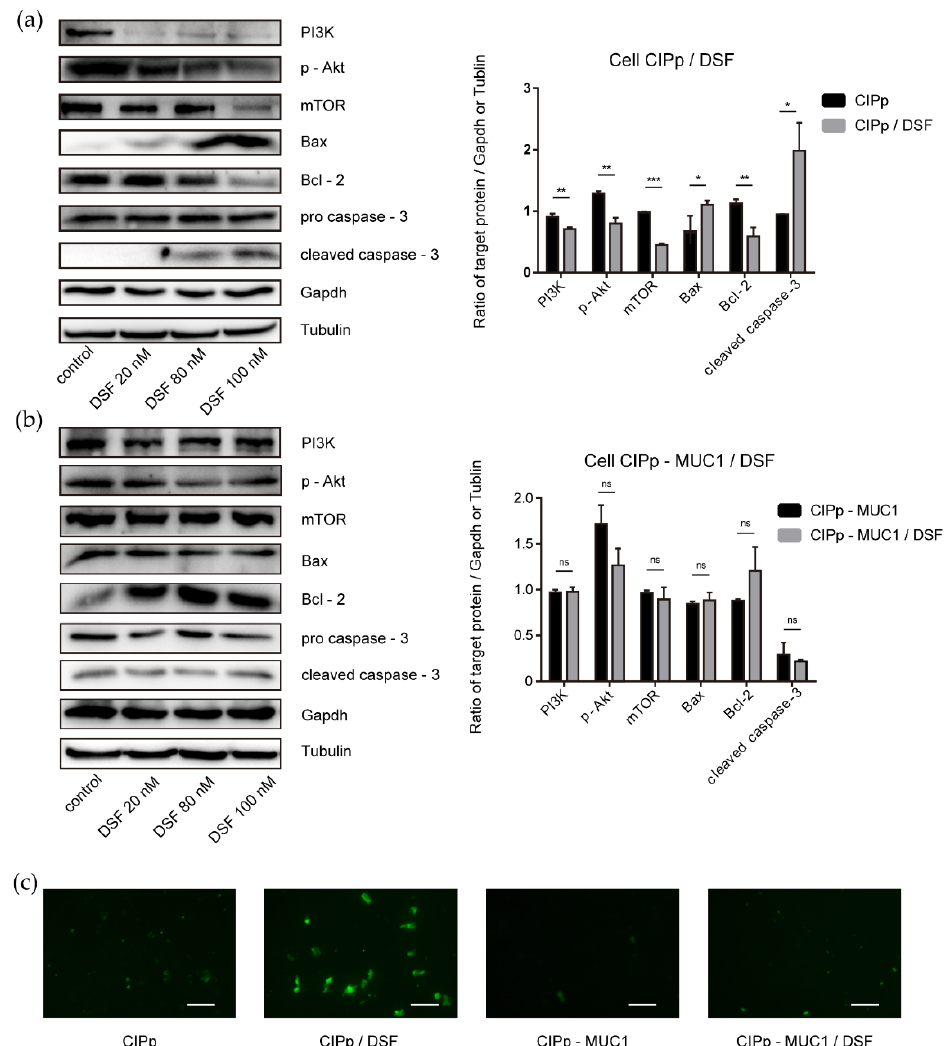
Figure 3. Effect of disulfiram on PI3K/Akt and apoptotic signal activity ( a , b ). Western blot analysis of CIPp and CIPp-MUC1 cells treated with or without different concentrations of disulfiram, the levels of PI3K, p-Akt, mTOR, Bax, Bcl-2, pro caspase-3, and cleaved caspase-3 were detected. ( a ) left panel, Western blot result of CIPp cells; right panel, densitometry analysis. ( b ) left panel, Western blot result of CIPp-MUC1 cells; right panel, densitometry analysis. ( c ) TUNEL assay of CIPp or CIPp-MUC1 cells treated with or without 100 nM disulfiram for 48 h: green signals indicated apoptotic cells (excitation wavelength: 488 nm). Data were presented as the mean ± SD of three independent experiments. * p < 0.05, ** p < 0.01, *** p < 0.001. Bar = 100 µ m. “ns” stands for not